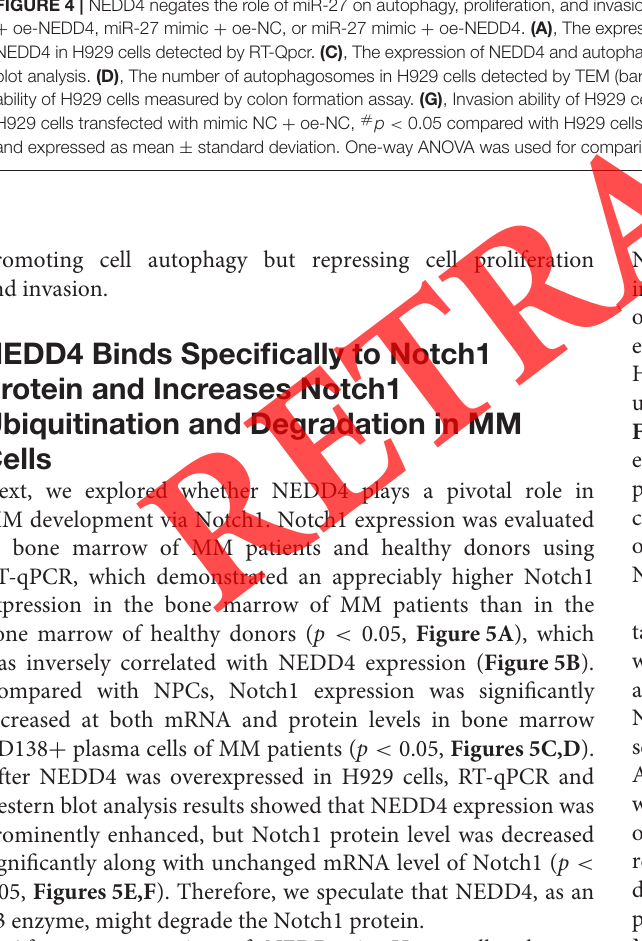
FIGURE 4 | NEDD4 negates the role of miR-27 on autophagy, proliferation, and invasion of MM cells. H929 cells were transfected with mimic NC + oe-NC, mimic NC + oe-NEDD4, miR-27 mimic + oe-NC, or miR-27 mimic + oe-NEDD4. (A) , The expression of miR-27 in H929 cells measured by RT-qPCR. (B) , The expression of NEDD4 in H929 cells detected by RT-Qpcr. (C) , The expression of NEDD4 and autophagy-related proteins (ATG5, Beclin1, LC3 II/LC3 I, and P62) detected by western blot analysis. (D) , The number of autophagosomes in H929 cells detected by TEM (bar = 1 µ m). (E) , Autophagic flow in H929 cells (bar = 25 µ m). (F) , Proliferation ability of H929 cells measured by colon formation assay. (G) , Invasion ability of H929 cells assessed by Transwell assay (bar = 50 µ m). * p < 0.05 compared with H929 cells transfected with mimic NC + oe-NC, # p < 0.05 compared with H929 cells transfected with miR-27 mimic + oe-NC. The data were measurement data and expressed as mean ± standard deviation. One-way ANOVA was used for comparison among multiple groups. The cell experiment was repeated three times.